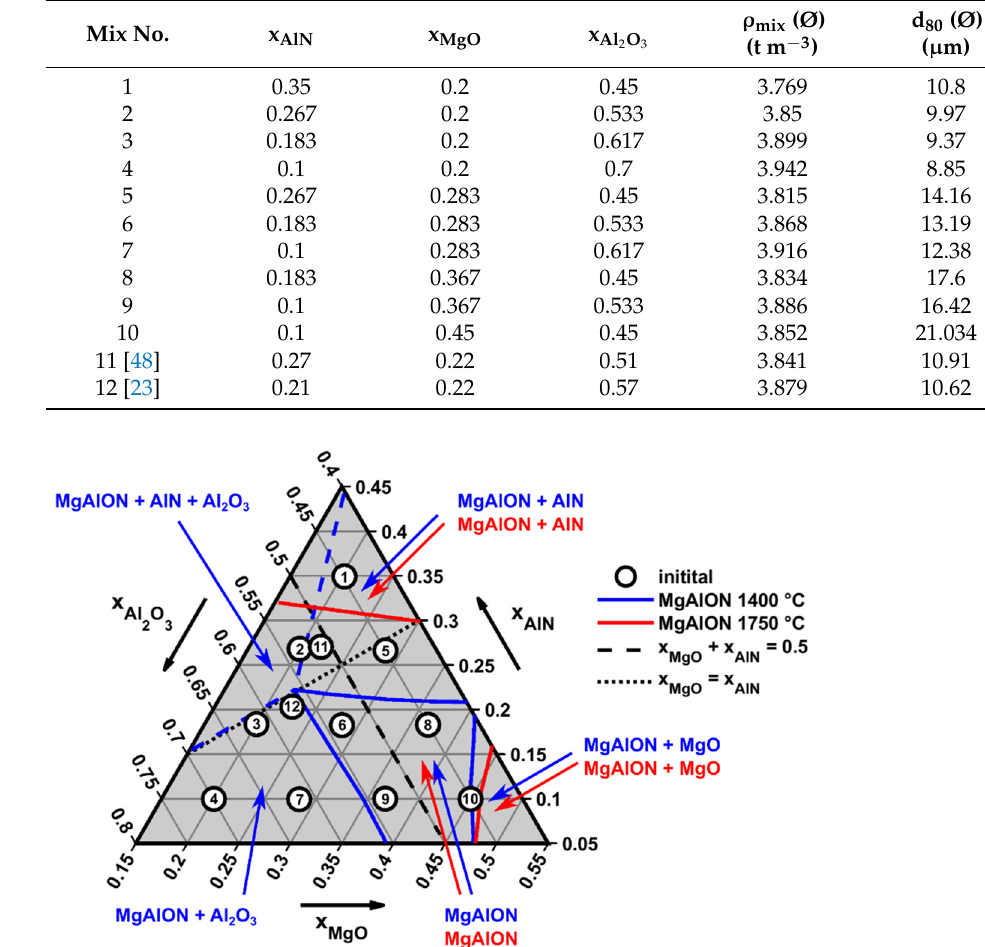
Figure 5. Compositions of the initial powder mixtures used, shown in a simplified phase diagram for the ternary MgO-AlN-Al 2 O 3 system, according to Table 3. The homogeneity ranges of MgAlON and the adjacent multiphase regions for 1400 °C and 1750 °C were estimated according to the phase diagrams proposed by Willems [4].